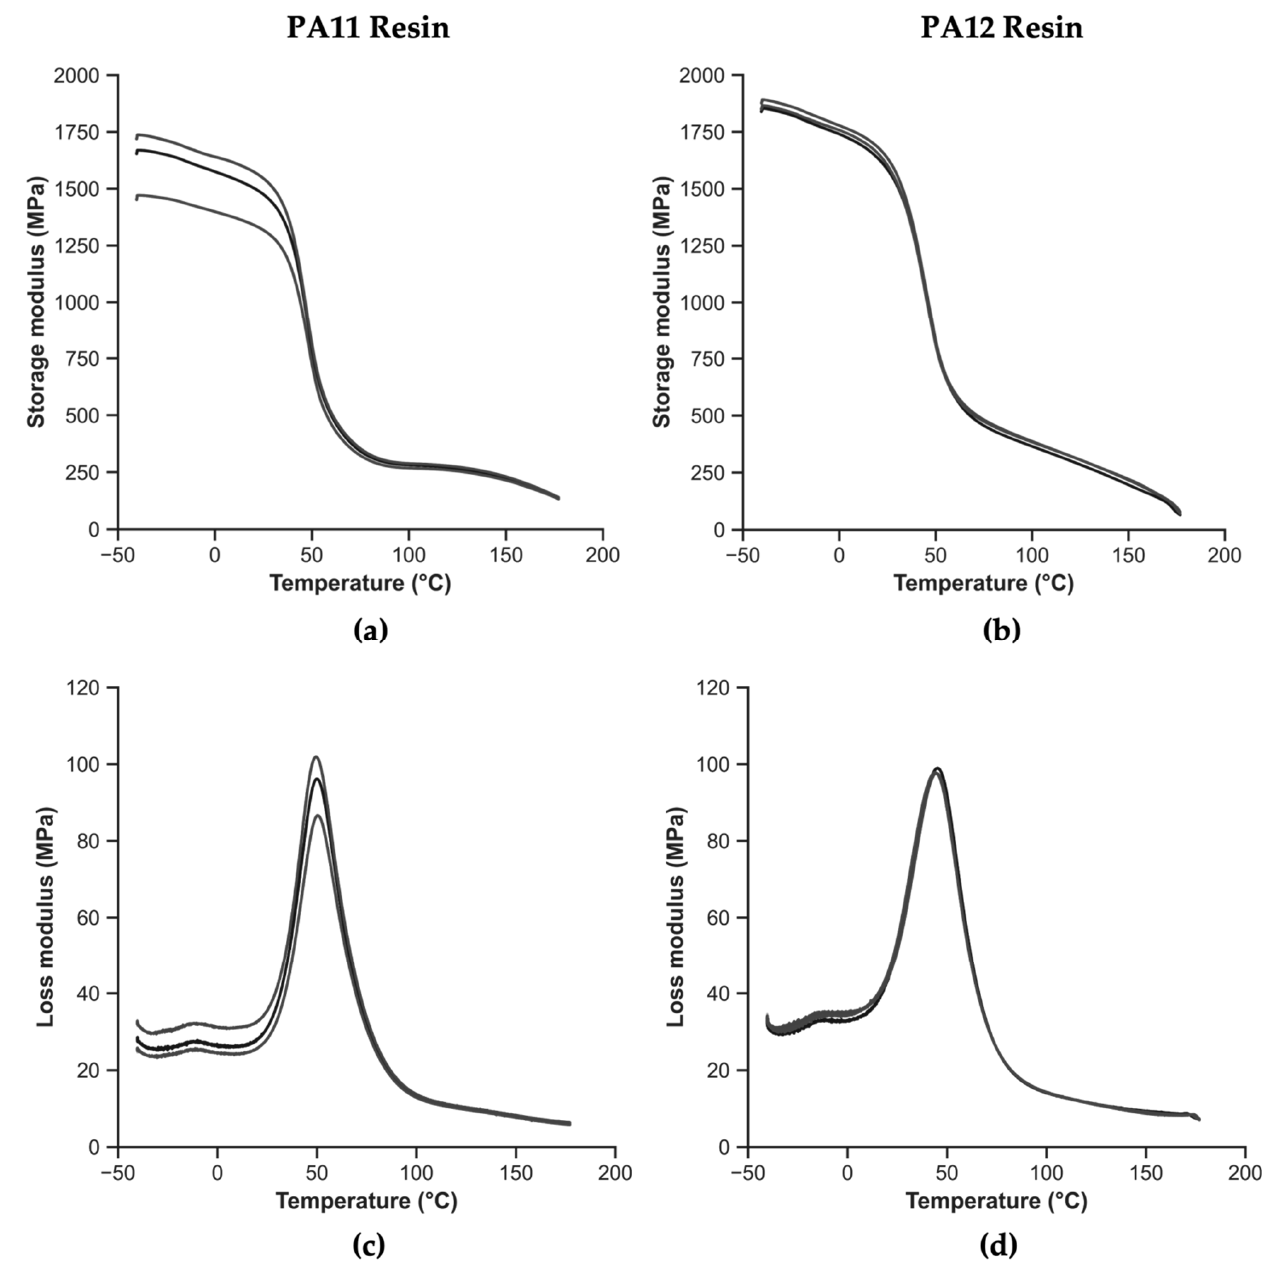
Figure 9. Thermomechanical behavior of polyamides: ( a ) storage modulus as a function of temper- ature for PA11, ( b ) storage modulus as a function of temperature for PA12, ( c ) loss modulus as a function of temperature for PA11, and ( d ) loss modulus as a function of temperature for PA12. The temperature indicated by the inflection point in the storage modulus curve can be used to determine the T g . The inflection point is determined as the intersection of the glassy and transition regions. However, for the sake of representativeness, the maximum of the loss modulus has been taken as indicative of T g . Table 6 displays the storage modulus value at the inflection point for storage modulus, the peak value of the loss modulus, and the T g determined in both of these